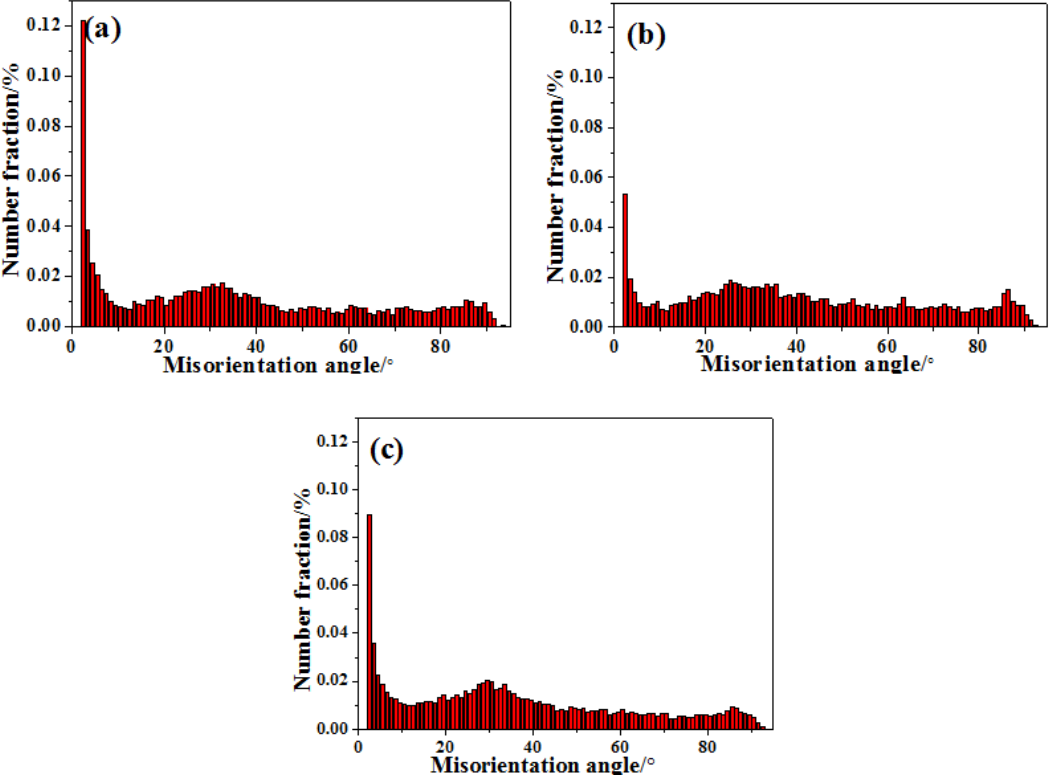
Figure 5. Disorientation map of grain boundary in AZ31-xCaO alloys. ( a ) AZ31; ( b ) AZ31-0.5%CaO; and, ( c ) AZ31-1%CaO.